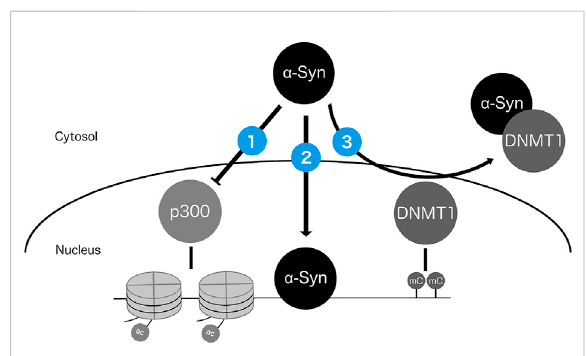
FIGURE 3 Potential mechanisms by which nuclear α -Syn protein can impact the epigenome. α -Syn can (1) inhibit activity of histone acetyltransferase p300 (Kontopoulos et al., 2006; Jin et al., 2011; Paiva et al., 2017); (2) directly bind DNA (Martins et al., 2011; Davidi et al., 2020); and (3) sequester DNMT1 from the nucleus to the cytosol (Desplats et al.,